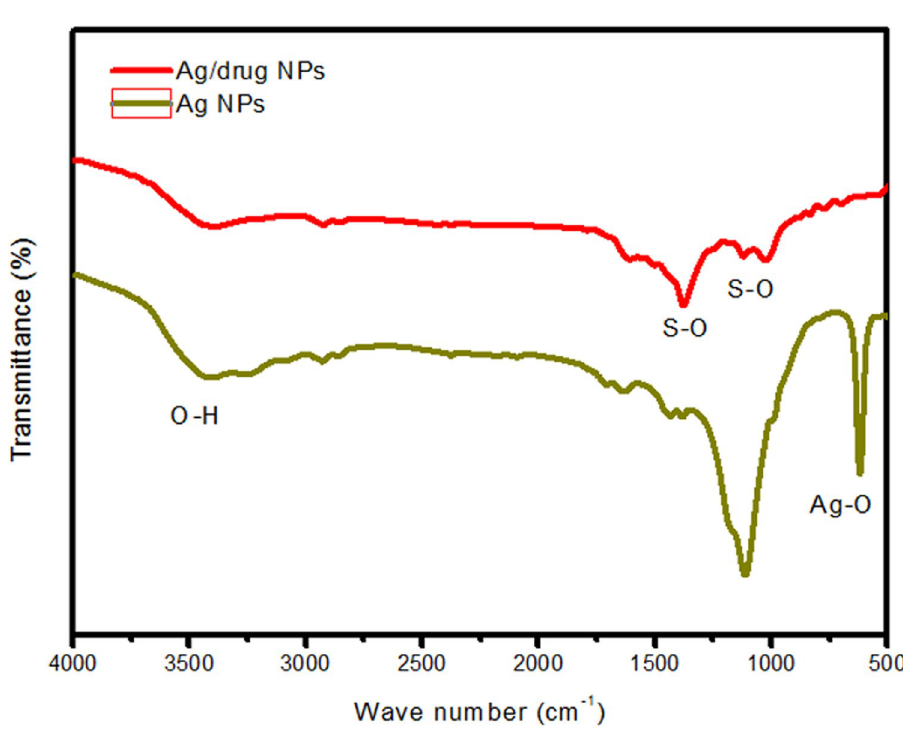
Figure 3. Fourier-transform infrared spectra (FTIR) of silver nanoparticles before and after Virokill disinfectant